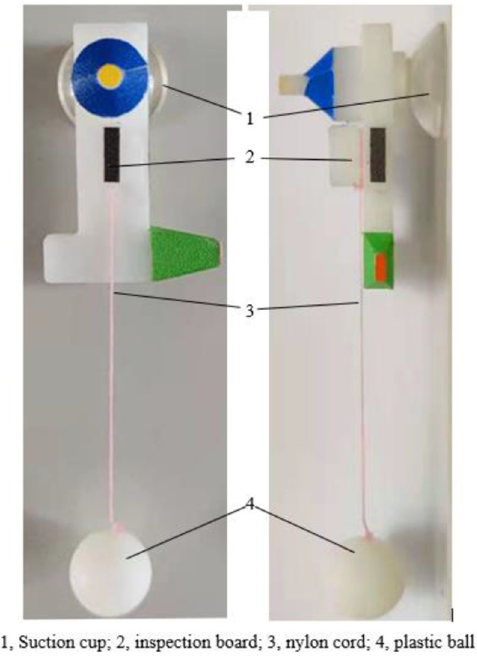
Fig. 11. Auxiliary tool for taking